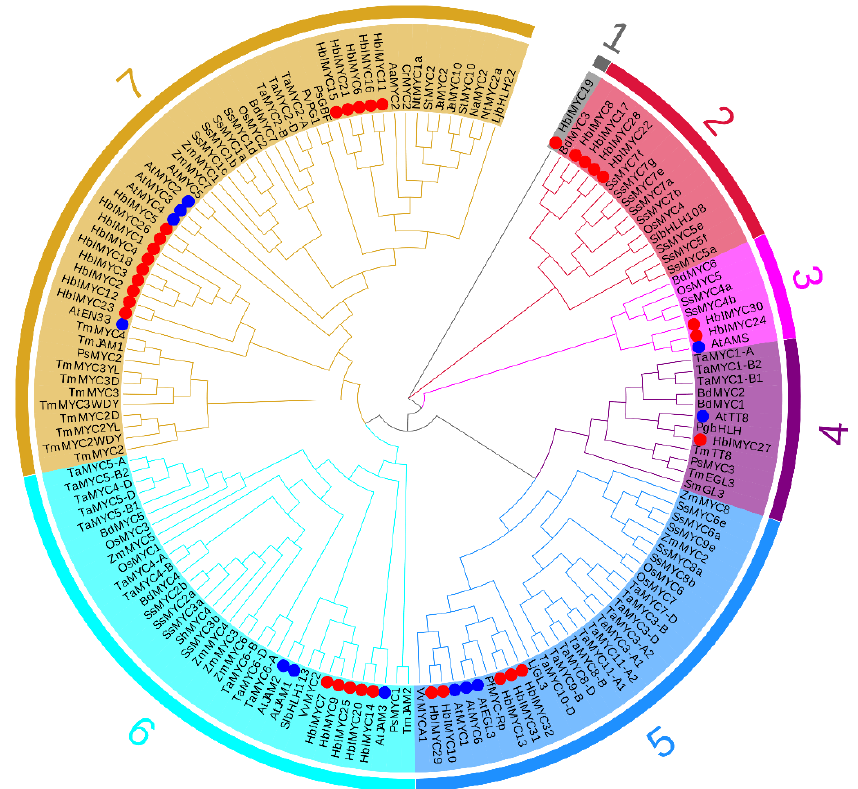
Figure 1. Phylogenetic relationship of HblMYCs . The MEGA7.0 with the neighbor-joining method was used to conduct the phylogenetic tree. Different numbers and background colors represented different groups of MYC proteins. Red points represented Hevea brasiliensis , and blue points represented Arabidopsis. The Latin abbreviations corresponding to species, 5 plant species of monocotyledonous: Bd, Brachypodium distachyon ; Os, Oryza sativa ; Ss, Saccharum spontaneum ; Sh, Saccharum spp. hybrid R570; Ta, Triticum aestivum ; Zm, Zea mays . In addition, 17 plant species of dicotyledonous: Aa, Artemisia annua ; At, Arabidopsis; Bo, Brassica oleracea ; Cb, Chrysanthemum boreale ; Cr, Catharanthus roseus ; Hb, Hevea brasiliensis ; Le, Lithospermum erythrorhizon ; Lj, Lotus japonicas ; Mt, Medicago truncatula ; Nt, Nicotiana tabacum ; Pf, Perilla frutescens ; Pg, Punica granatum ; Ps, Picea sitchensis ; Ps, Pisum sativum ; Pt, Populus tomentosa ; Pv, Phaseolus vulgaris ; Rc, Ricinus communis ; Sl, Solanum lycopersicum ; Sm, Salvia miltiorrhiza ; Sm, Selaginella moellendorffii ; St, Solanum tuberosum ; Tc, Taxus cuspidata ; Vv, Vitis vinifera .